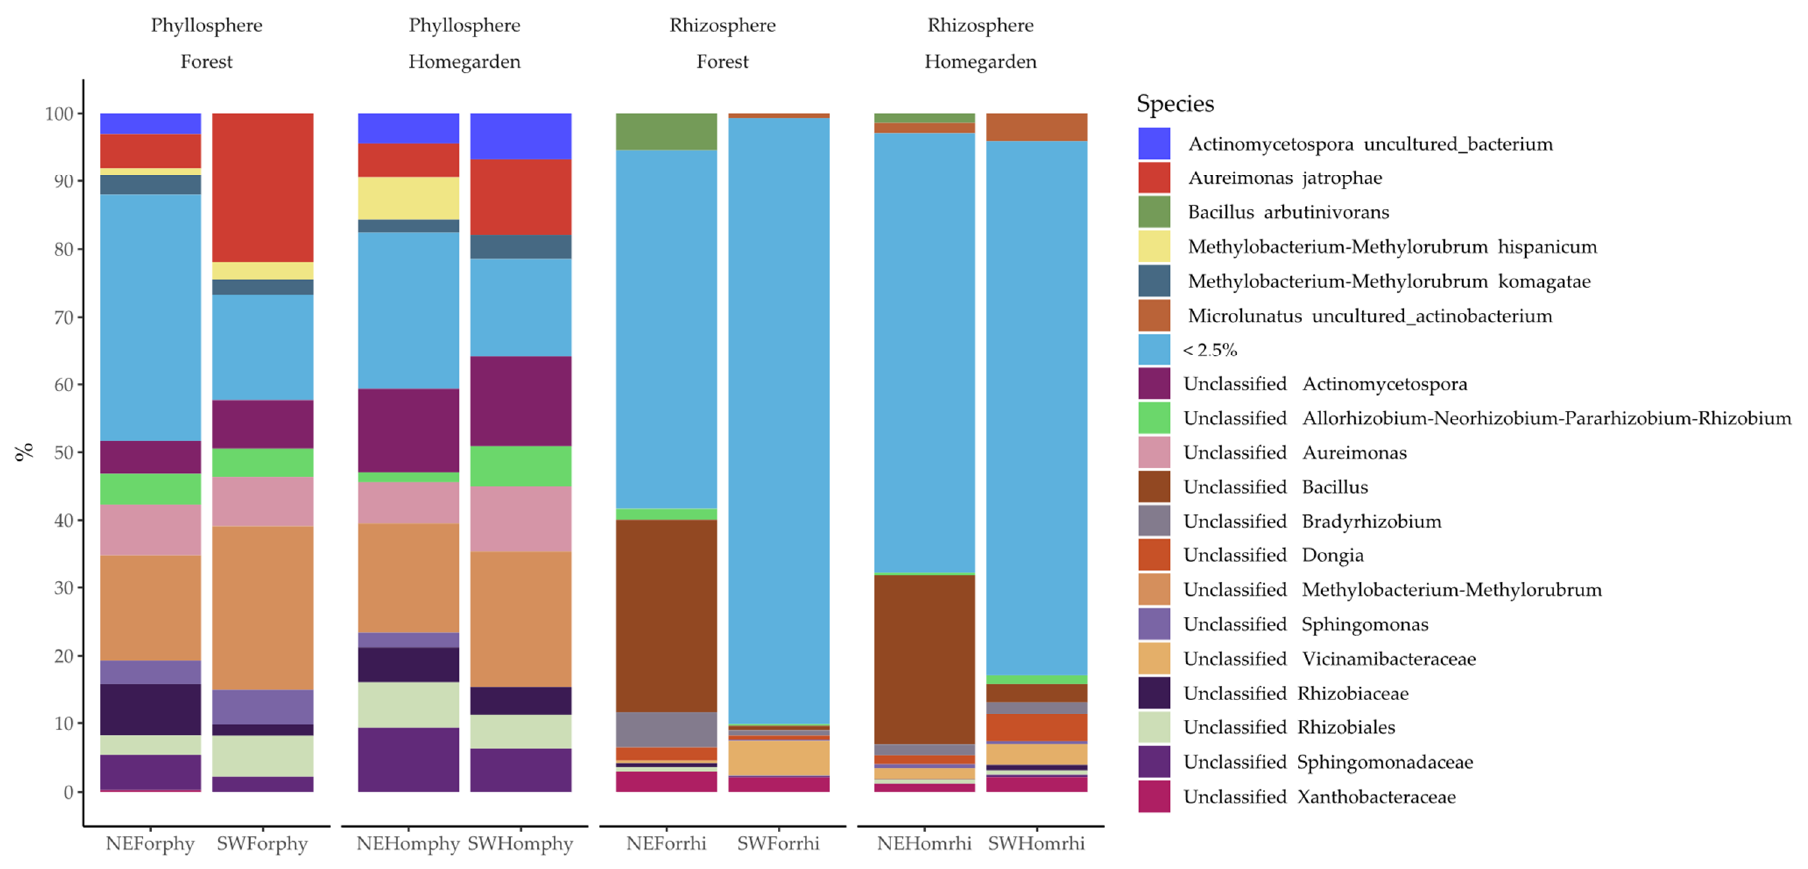
Figure 3. Relative frequency of 618 bacteria OTUs from phyllosphere and rhizosphere microbiota in Yucatán´s forest and homegarden populations of Cordia dodecandra .